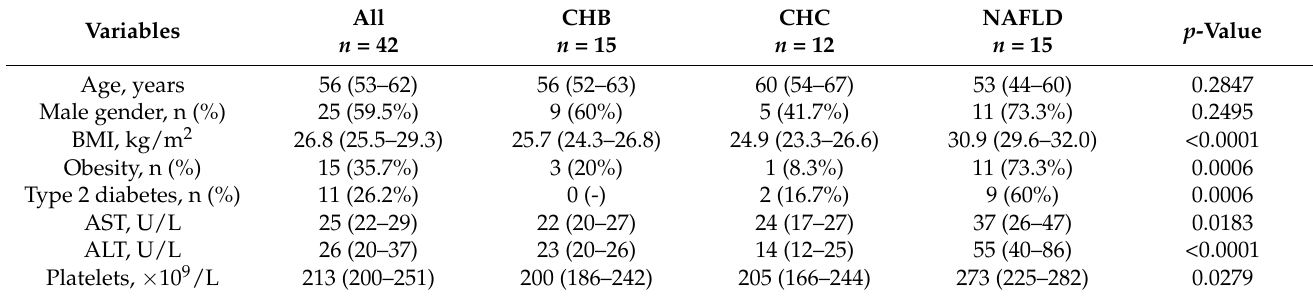
Table 1. Clinical and biochemical characteristics of the study cohort according to the liver disease